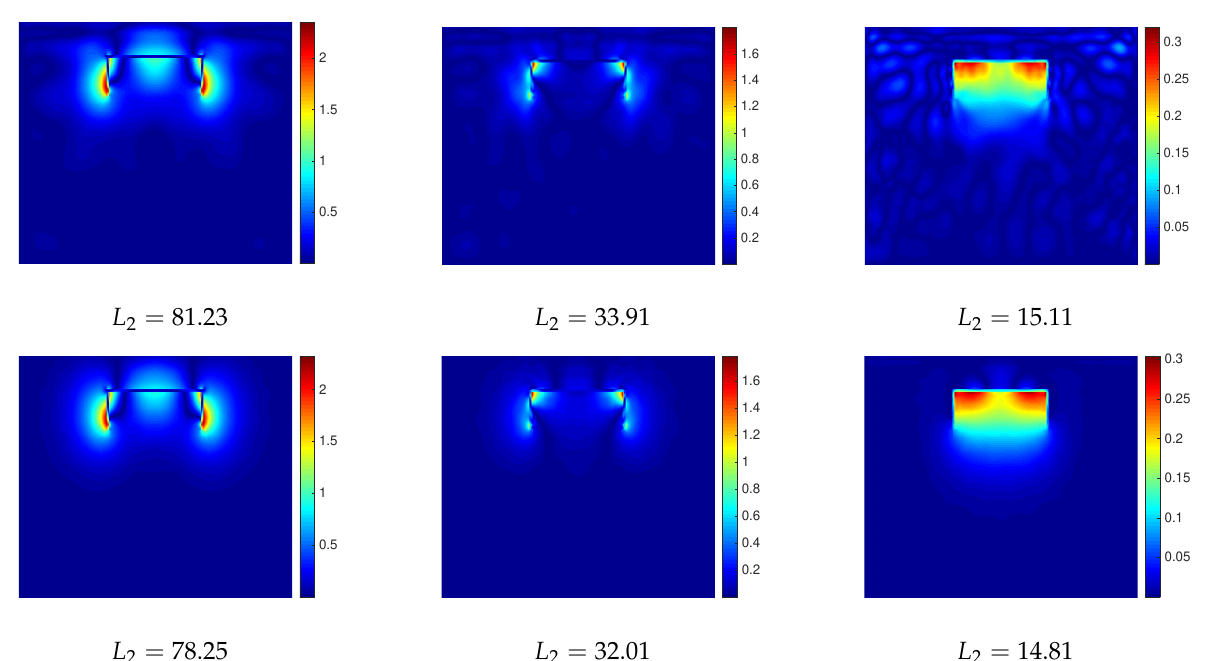
Figure 9. Results of the two-dimensional GES experiment without source: visual comparison (absolute differences) of the results between EE and KSMOR (cid:63) for varying number of s and q at t F = 2.609 10 6 for h = 0.04 with τ = 2609. The visualisations are ordered from left to right by × s = 5,10,20 and from top to bottom via q = 2,3,5,10 . Special care must be taken in rating { } { } the visualisations, because no uniform temperature scaling between the absolute differences of the solutions is given: we still opted to represent the solutions in this way, as the differences between the errors that occur are too large to employ a uniform scaling. For a better comparison, the L 2 -error is also displayed. Increasing the number of snapshots s or subspaces q gives better results in terms of maximum error and L 2 -error. Obviously, a reasonable selection of s is of great importance, since less snapshot data lead to strong artefacts at the